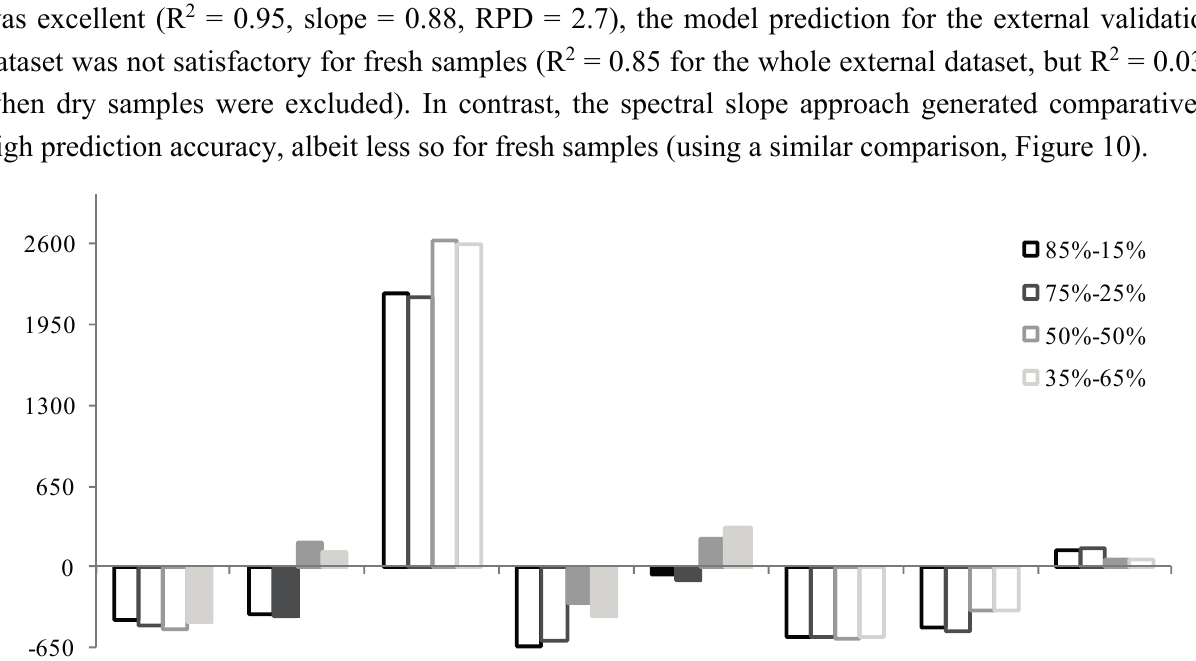
Figure 11. Regression coefficients of partial least squares (PLS) crude protein (CP) model for different ratios of dry to fresh vegetation samples (filled rectangle indicates less important